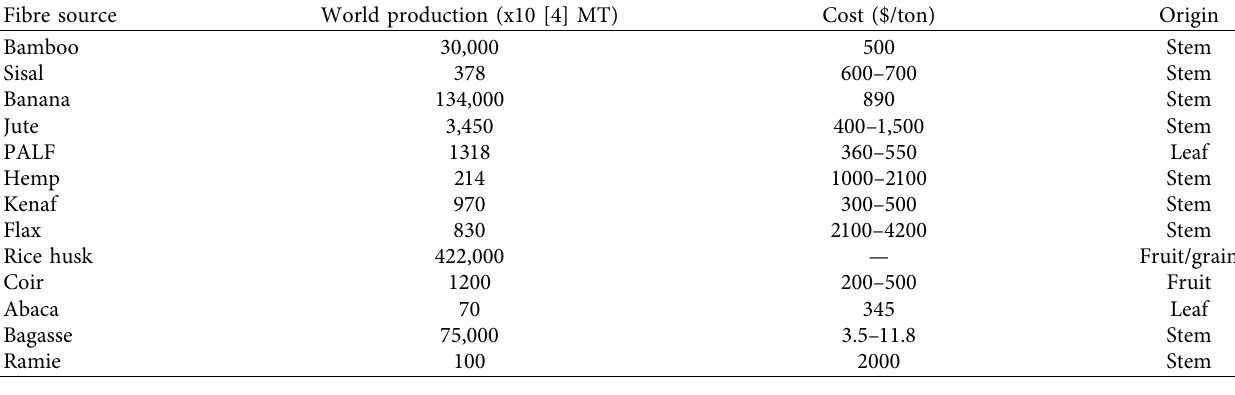
Table 1: Annual production of commonly used natural fibres and their sources [33–36].